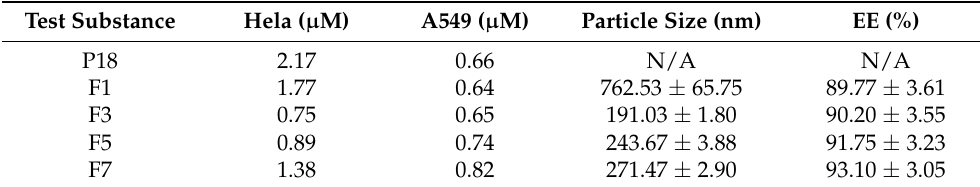
Figure 9. Viability of two cancer cell lines (HeLa and A549) treated with pure P18 solution, F1, F3, F5, and F7. The cell viability was measured using WST assay. ( A ) Dark and light cytotoxicity of HeLa cells and ( B ) dark and light cytotoxicity of A549 cells. Results are expressed as means ± standard deviations of three independent experiments ( n = 3). Table 5. IC 50 ( µ M) values of HeLa and A549 cells; particle size and entrapment efficiency (EE) of pure P18 solution, F1, F3, F5, and